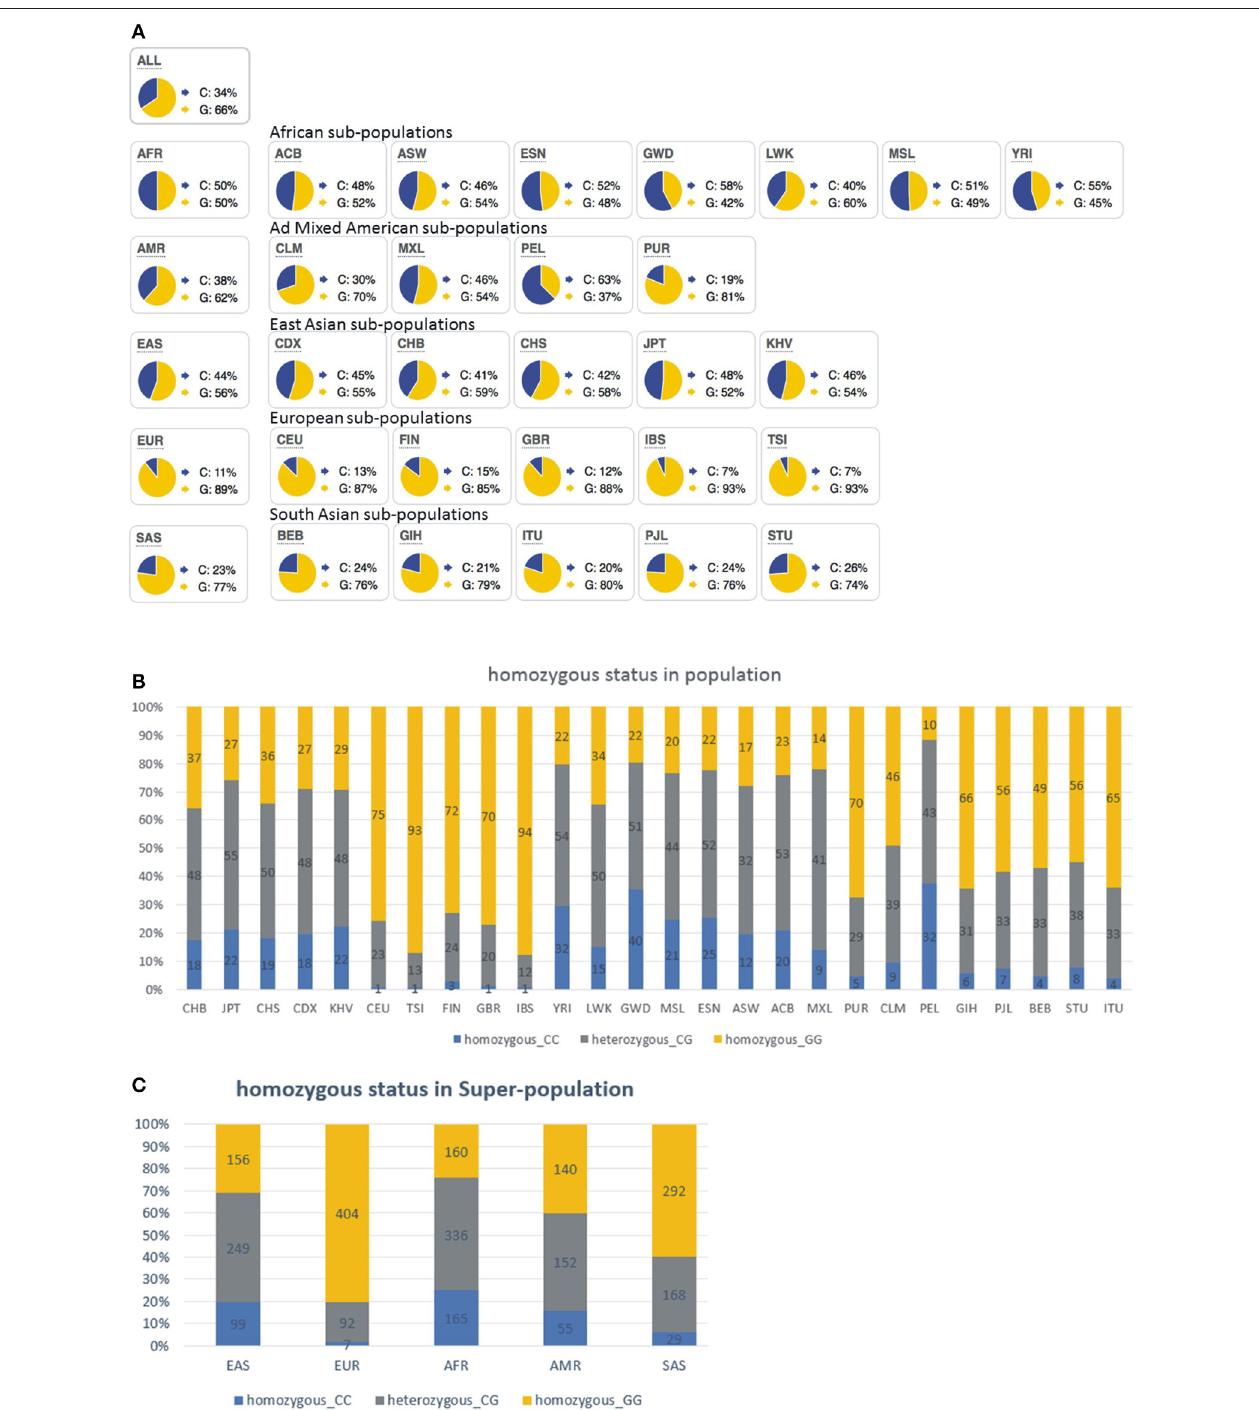
FIGURE 7 | Bioinformatic analysis of 1000 Genome Project Phase 3 allele frequencies coding for human Apobec-1 80M and 80I variants reveal world-wide differences. (A) Note that the C allele codes for 80M (shown in blue) while the G allele codes for 80I (shown in yellow). Details about frequencies are shown in Supplementary Table 2. SNP: rs2302515. Ref allele: C, ancestral allele: G. This analysis indicates that the European population predominantly encodes the 80I-Apobec-1 variant, compared to, for example, only 50% of the African population. (B) Representation of homo- and heterozygosity of APOBEC1 80M- and 80I- coding alleles. Bar graph shows the frequency of the alleles in populations, with the number showing the sequenced alleles in phase 3 of the 1,000 Genomes Project. Homozygous 80M-coding (CC, blue), heterozygous 80M-/80I-coding (CG, gray), and Homozygous 80I-coding (GG, yellow). (C) Representation of homo- and heterozygosity of APOBEC1 80M- and 80I- coding alleles in super-population. Bar graph shows the frequency of the alleles in populations, with the number showing the sequenced alleles in phase 3 of the 1000 Genomes Project. Homozygous 80M-coding (CC, blue), heterozygous 80M-/80I-coding (CG, gray), and homozygous 80I-coding (GG,